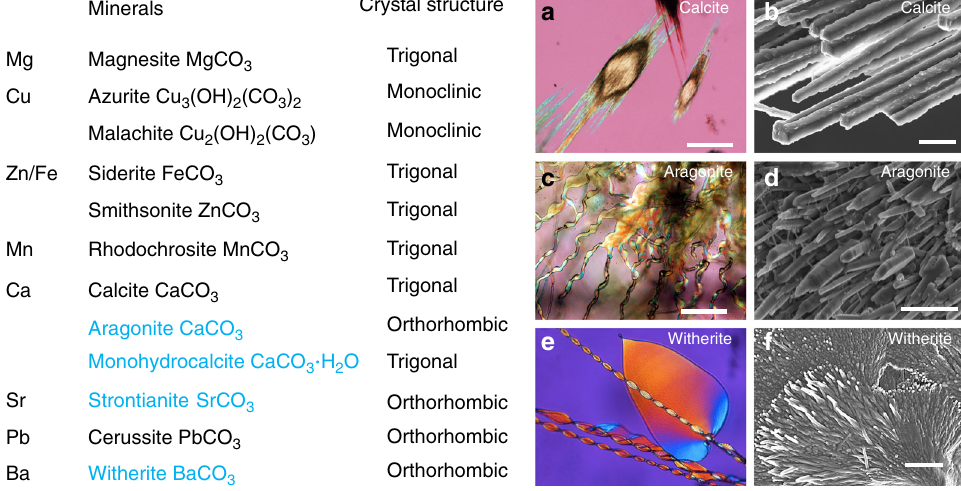
Fig. 1 Mineral phases of carbonate and their corresponding crystal structures. The calcite ( a , b ), aragonite ( c , d ), and witherite ( e , f ) formed at silica-rich alkaline conditions are shown in optical micrographs, and the corresponding textures are illustrated by FESEM images. So far, complex biomorphic structures were restricted to orthorhombic BaCO 3 , SrCO 3 , and CaCO 3 (aragonite) carbonates. We have found that biomorphs of the trigonal phase MHC can be also synthetized under certain range of temperature. Scale bars: 100 μ m ( a ), 200 μ m ( c ), and 1 μ m ( b , d , f